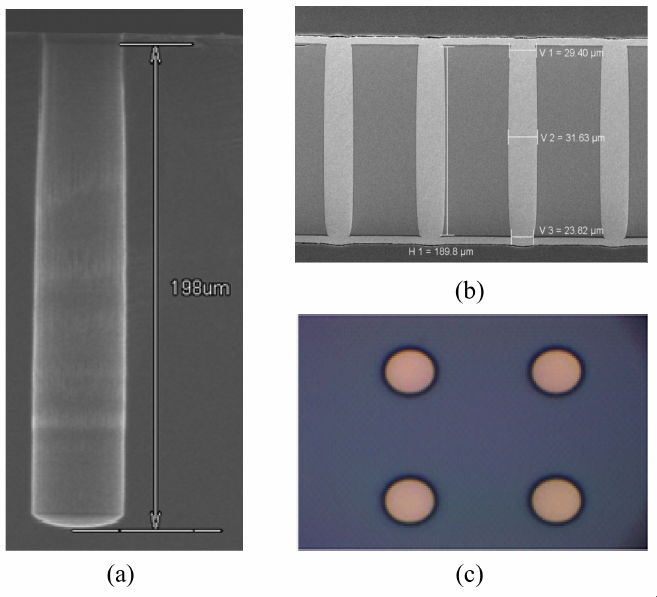
Figure 4. The images of the full-via-plated TSVs. ( a ) X-ray image, ( b ) SEM image, ( c ) optical microscope